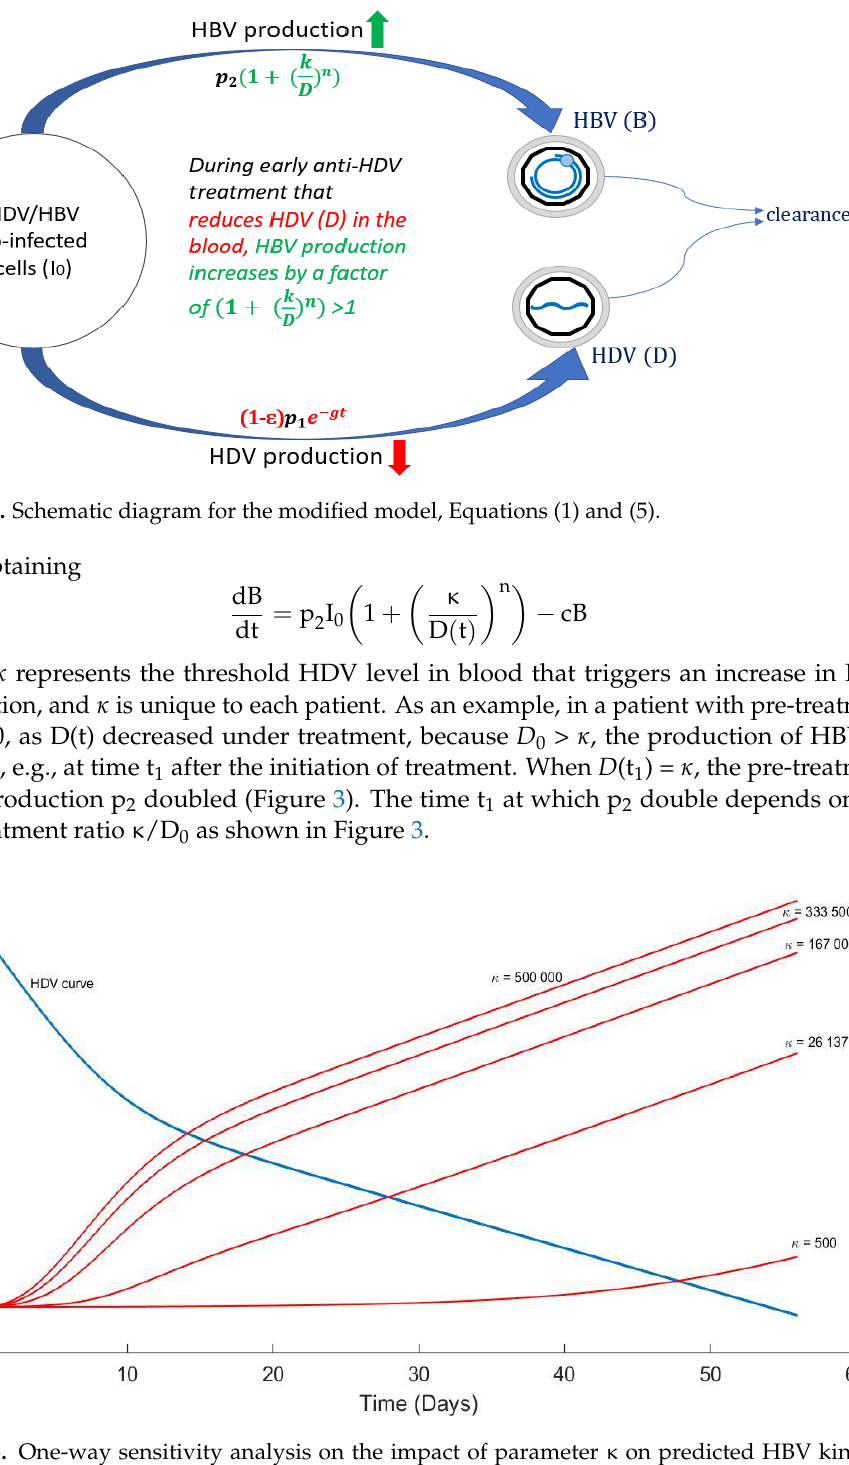
Figure 1. The model Equations (1) and (2) failed to reproduce HBV kinetics in additional patients reported in Yurdaydin et al. [5]. Model parameter values were D 0 = 1.2 × 10 6 , B 0 = 282, c = 0.51, g = 0.089, ε = 0.97.